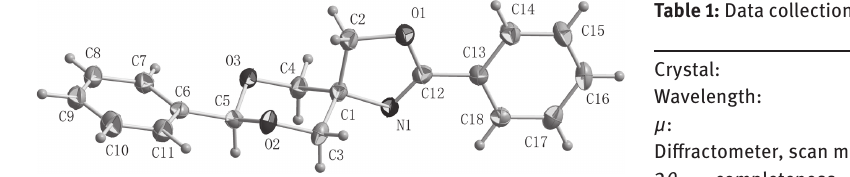
Table 1: Data collection and handling.